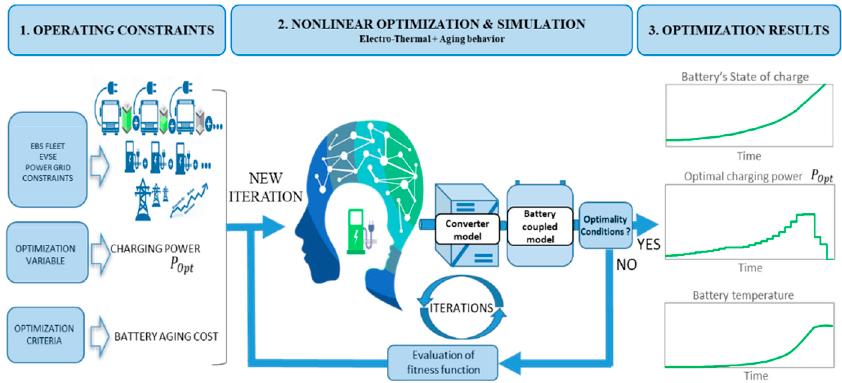
Figure 2. Smart charging methodology for the management of EBs fleet charging.